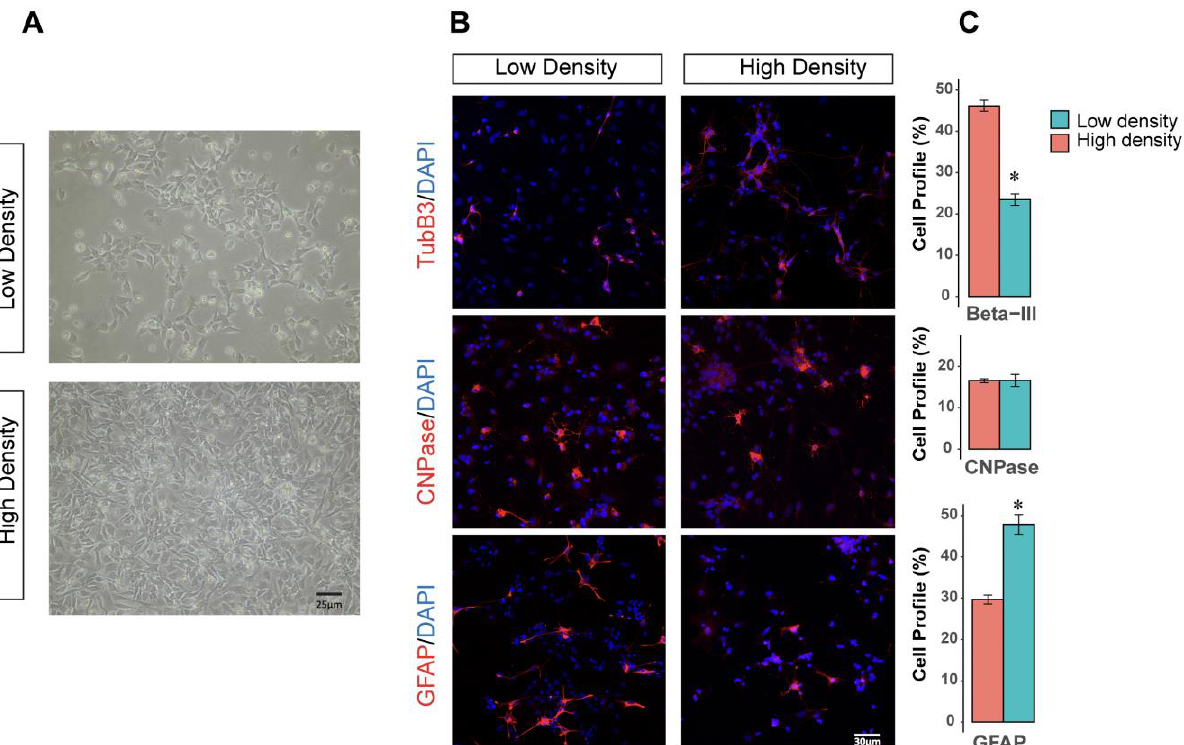
Figure 1 . Tripotency of hiPSC-NPCs at low and high densities. ( A ) Visual representation of high vs. low density hiPSC-NPCs prior to cellular differentiation. ( B ) Immunocytochemistry of differentiated hiPSC-NPCs (blue = DAPI; red = cell marker). ( C ) Cell profile (%) of total cells (DAPI+) as a ratio of cell marker + cells. * = p -value <0.05, N = 3 per group.